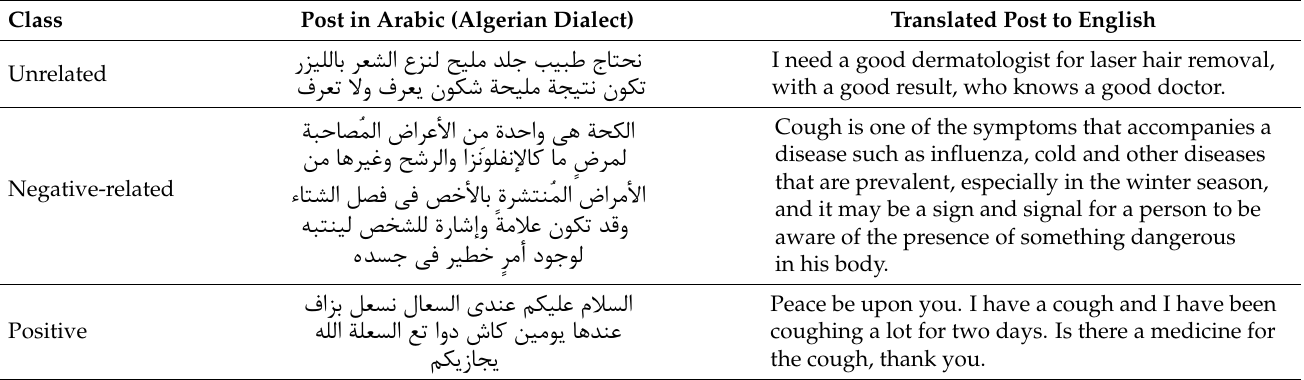
Table 2. Examples of posts in each sentiment